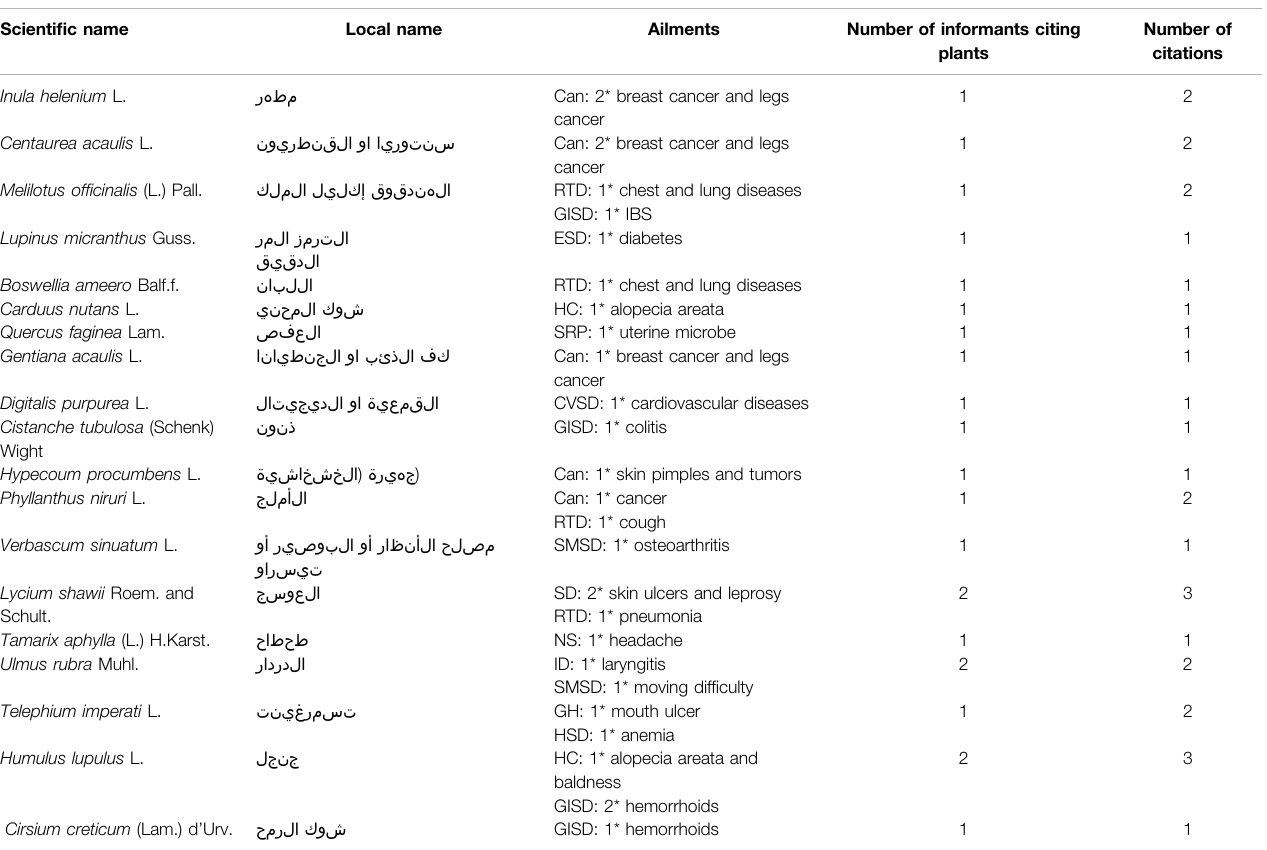
TABLE 3 | New recorded medicinal plants used by traditional healers in Algeria